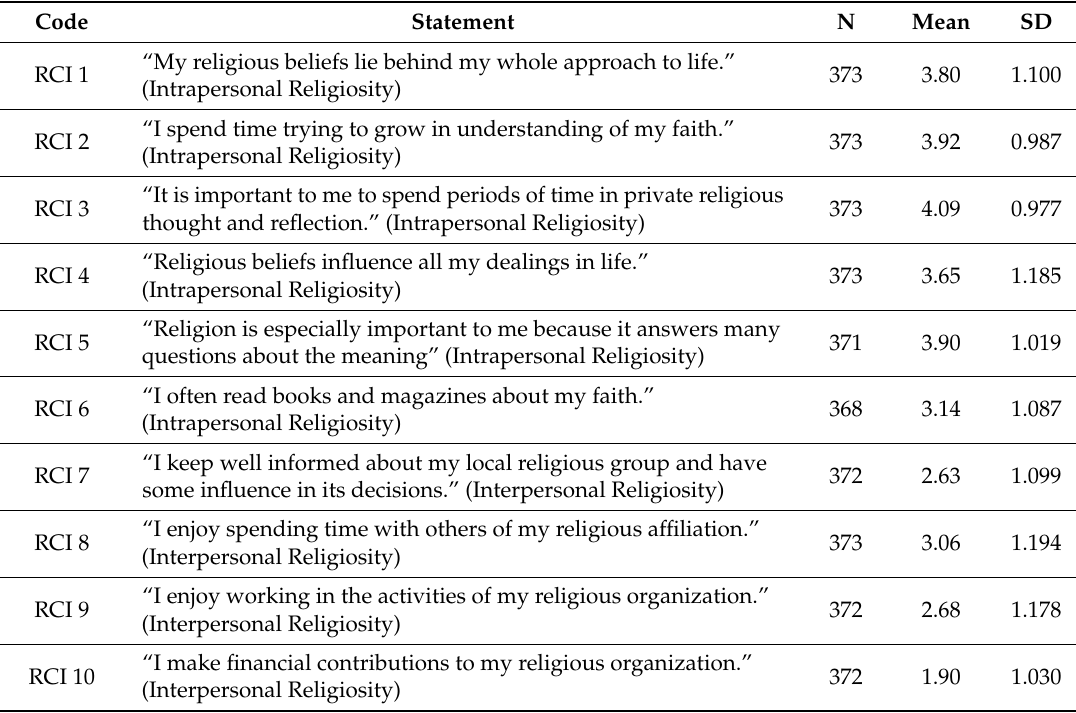
Table 2. The Religious Commitment Inventory—10